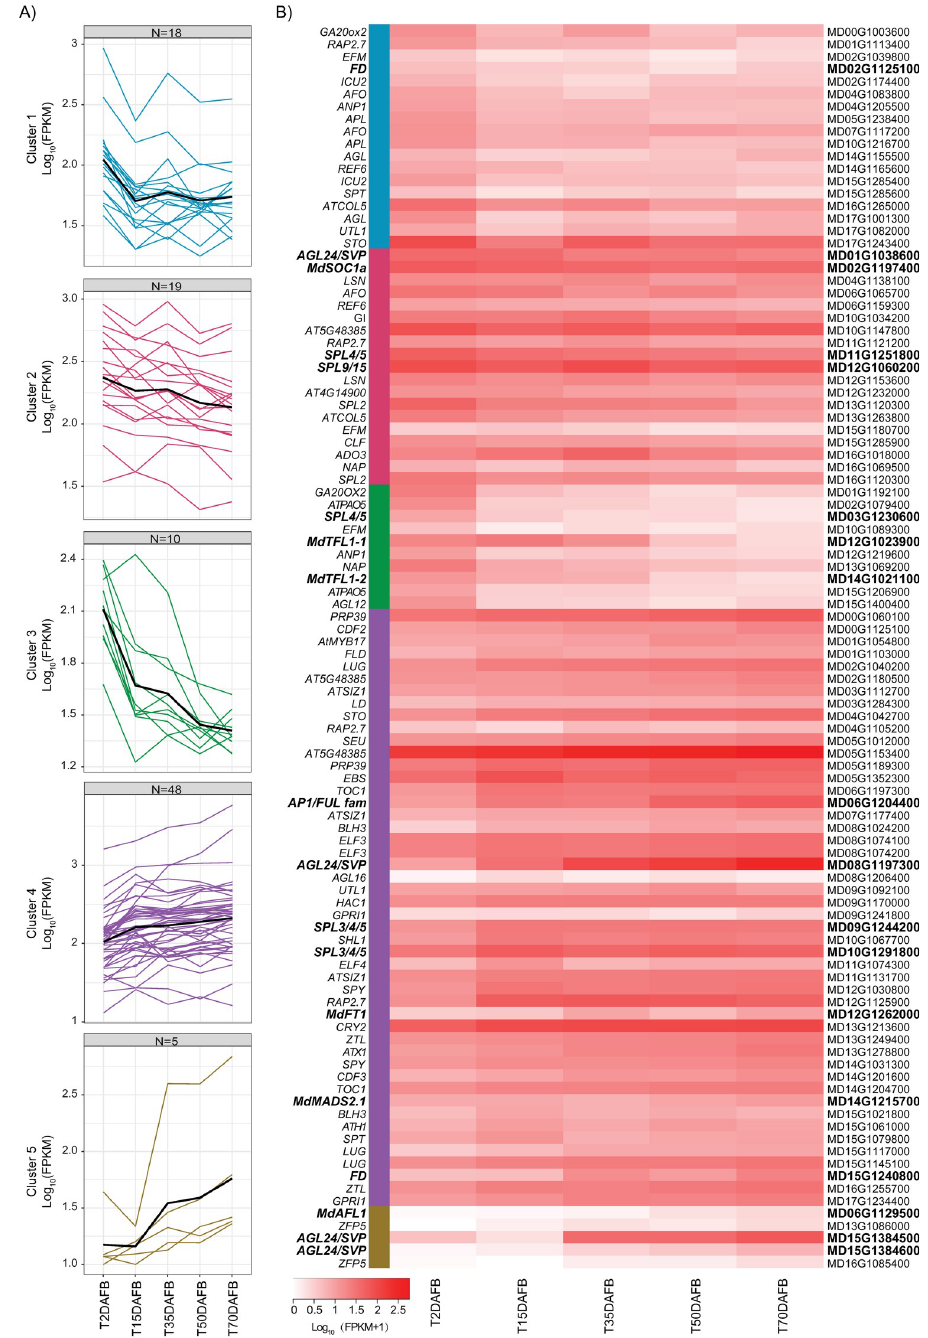
Fig 4. Expression patterns of flowering gene homologs in flowering-induced apices. A) Expression plots for flowering gene homologs that exhibited significant changes in expression across the study period. Expression profiles were grouped into similar patterns using K -means clustering ( k = 5). For each cluster, the average expression pattern is represented by a black line. Expression levels (FPKM) were log 10 transformed. N = number of flowering genes assigned to the respective cluster. B) Heatmap of expression values sorted by K -means cluster assignment. Homolog nomenclature is represented by gene symbols or Arabidopsis gene IDs on the left of the heatmap. On the right of the heatmap are the GDDH13 reference loci. Gene symbols and IDs shown in bold represent the subset of intensively studied flowering gene homologs listed in Table 2.